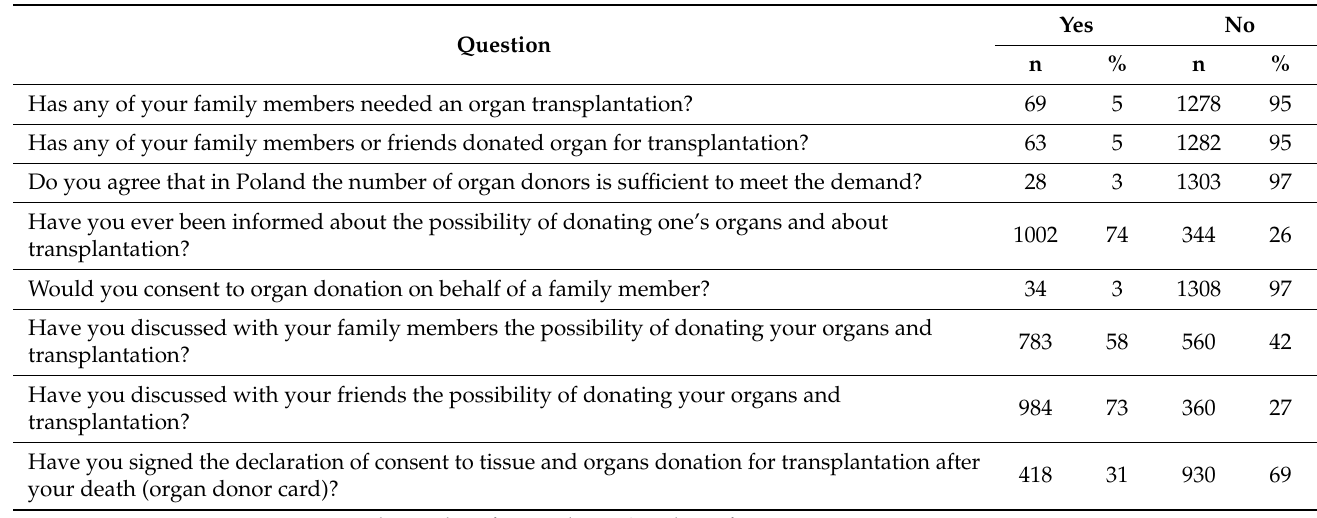
Table 2. Experience and opinions of the respondents on organ